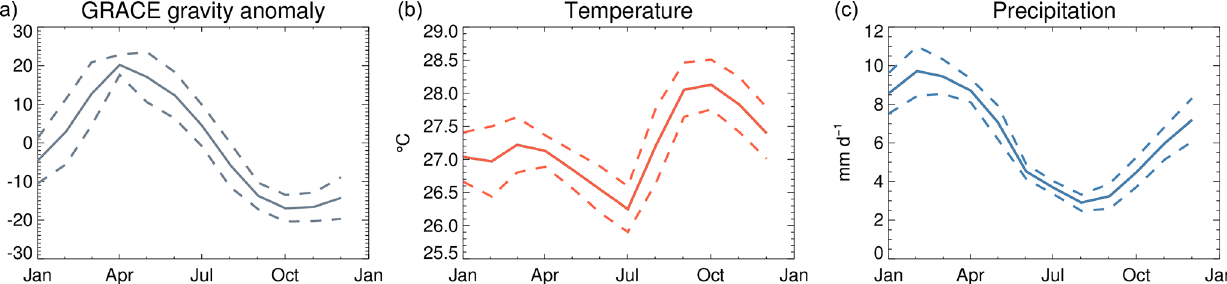
Figure A6. Mean seasonal cycle of GRACE gravity anomaly ( a , cm), temperature ( b , ◦ C) and precipitation ( c , mmd − 1 ) within the Amazon basin for 2010–2018. Dashed lines show 1 standard deviation from the mean values. Temperature is taken from the Global Historical Climatology Network (GHCN) gridded V2 product, whilst precipitation is from the Global Precipitation Climatology Project v2.3 combined precipitation dataset product. Both were provided by the NOAA/OAR/ESRL Physical Sciences Laboratory